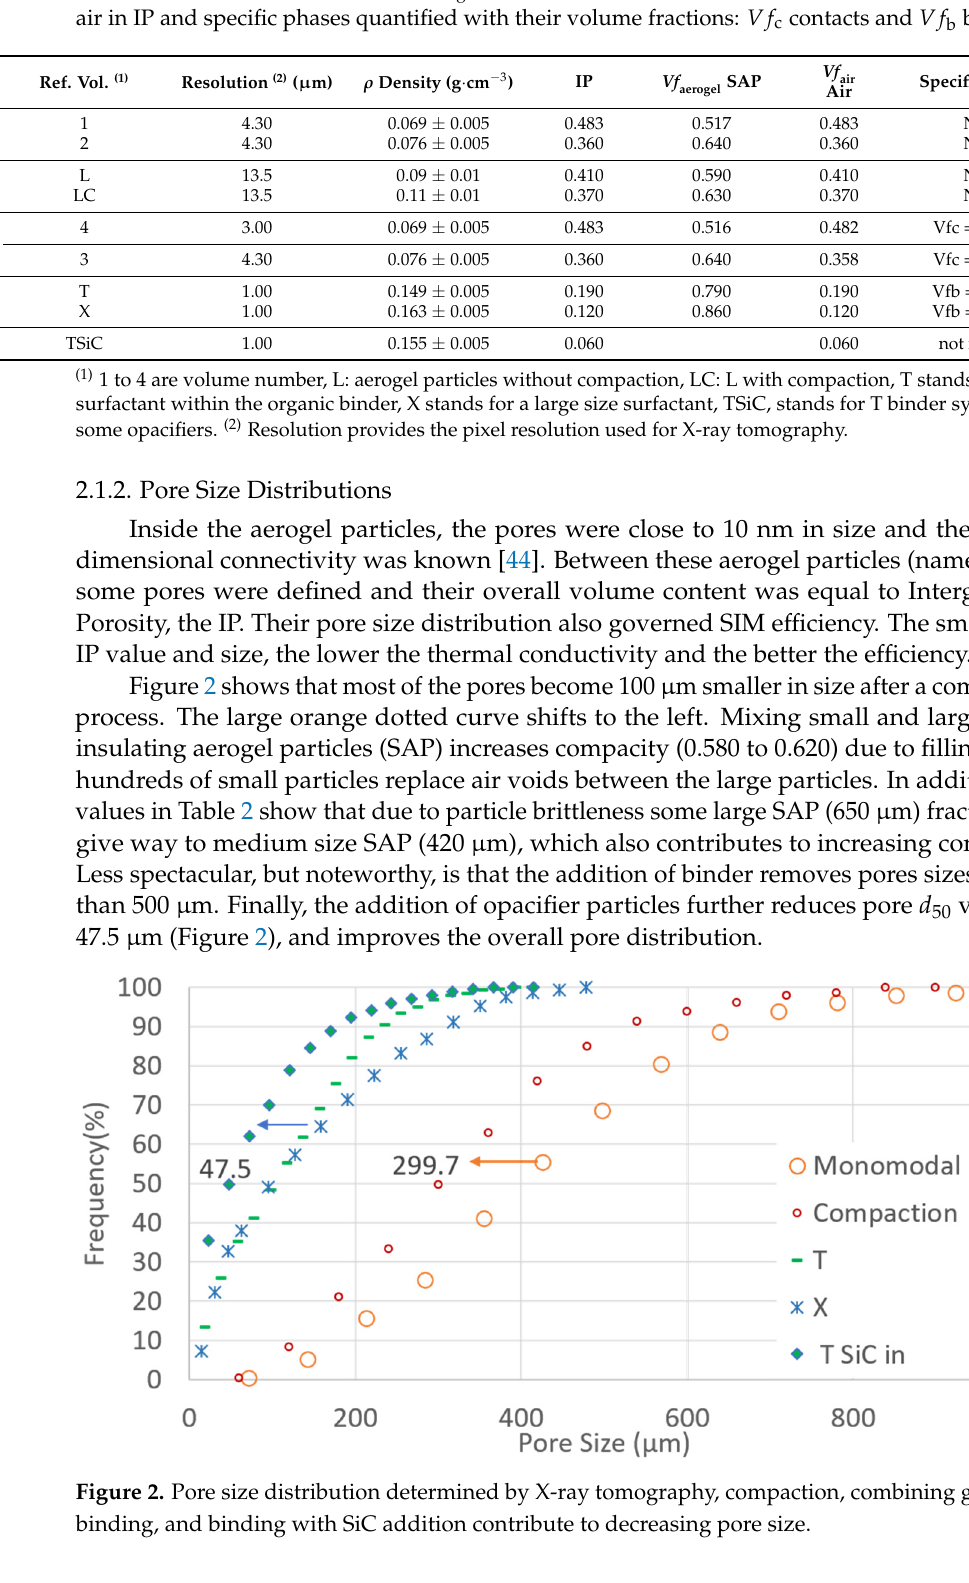
Table 1. First SIM Formulations characterized by their type, and the volume reference and X-ray